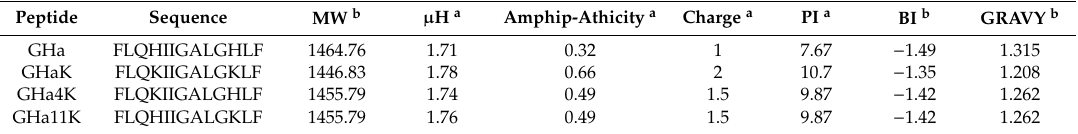
Table 1. Sequences and physicochemical properties of GHa and its